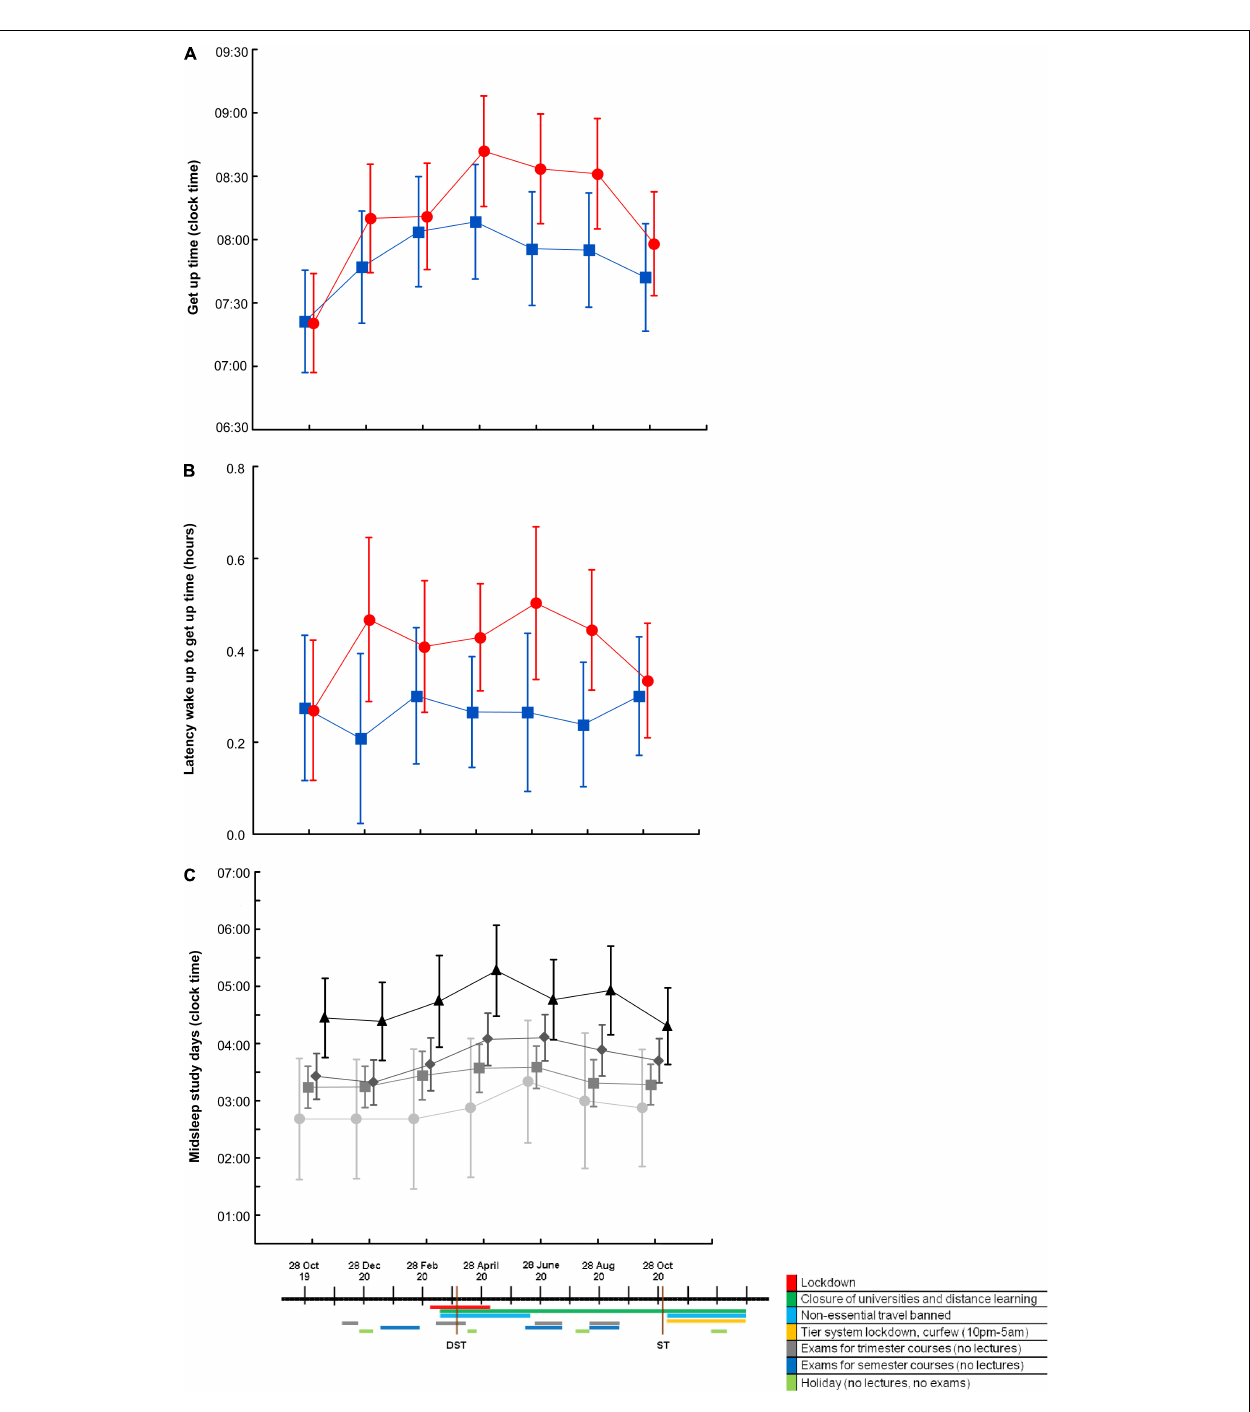
FIGURE 2 | Sleep timing indices by circadian hygiene education group and by chronotype, over time and in relation to relevant 2020 events. Get-up time (A) and latency between wake-up and get-up time (B) in the “A regular life” (red circles; n = 30 at each time point) and the “Bright days and dark nights” (blue squares; n = 28 at each time point) groups. Differences were significant up to August 2020, that is T10 [get-up time: F ( 5 , 365 ) = 17.0, p time < 0.0001 ( η p 2 = 0.189), F ( 1 , 73 ) = 4.2, p intervention = 0.042 ( η p 2 = 0.055), F ( 5 , 365 ) = 1.2, p interaction n.s. ( η p 2 = n.s.); latency: F ( 5 , 365 ) = 2.1, p time = 0.06 ( η p 2 = n.s.), F ( 1 , 73 ) = 5.9, p intervention = 0.02 ( η p 2 = 0.075), F ( 5 , 365 ) = 1.7, p interaction n.s. ( η p 2 = n.s.)] and were abolished/reduced when October 2020 (T12), which coincided with the week after the transition from daylight saving time (DST) to standard time (ST), was included [get-up time: F ( 6 , 336 ) = 11.9, p time < 0.0001, F ( 1 , 56 ) = 2.4, p intervention n.s.; F ( 6 , 336 ) = 1.5, p interaction n.s.; latency: F ( 6 , 336 ) = 0.9, p time n.s., F ( 1 , 56 ) = 3.1, p intervention = 0.08; F ( 6 , 336 ) = 2.0, p interaction n.s.]. Midsleep on study days (C) in definitely morning (light gray circles), morning (gray squares), evening (dark gray diamonds), and definitely evening (black triangles) chronotypes [ F ( 3 , 345 ) = 5.3, p time < 0.001, F ( 3 , 69 ) = 4.0, p chronotype < 0.005, F ( 15 , 345 ) = 1.2, p interaction n.s., at T10; F ( 6 , 312 ) = 4.7, p time < 0.001, F ( 3 , 52 ) = 5.6, p chronotype < 0.005, F ( 18 , 312 ) = 0.9, p interaction n.s., at T12]. Values are expressed as means ± 95% confidence intervals. n.s., not statistically